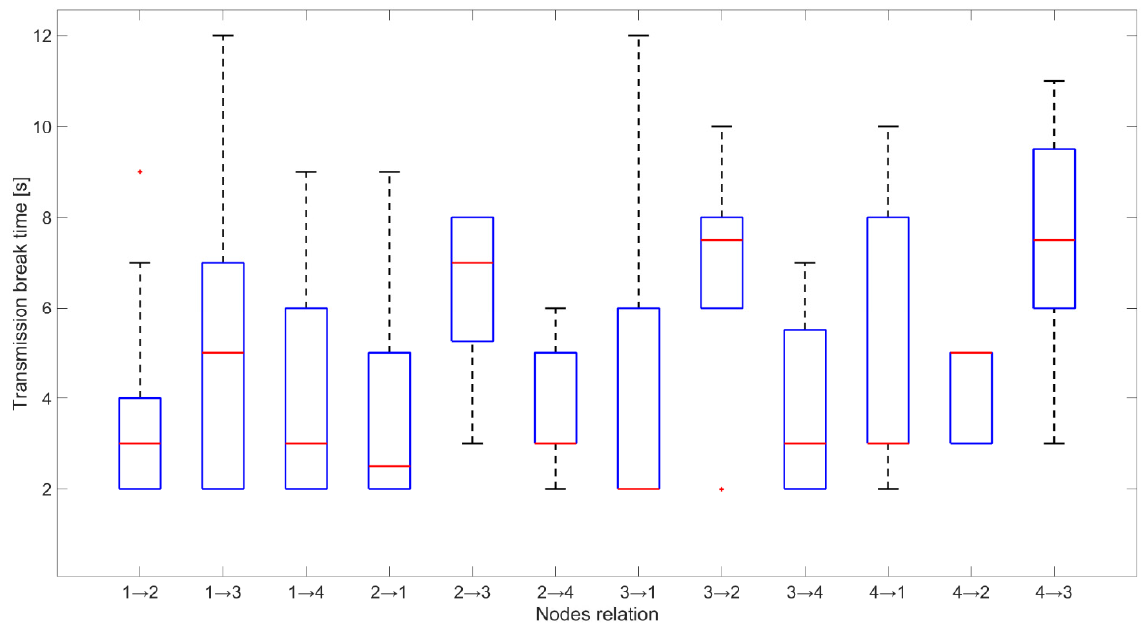
Figure 16. Time of node synchronization for each relationship.